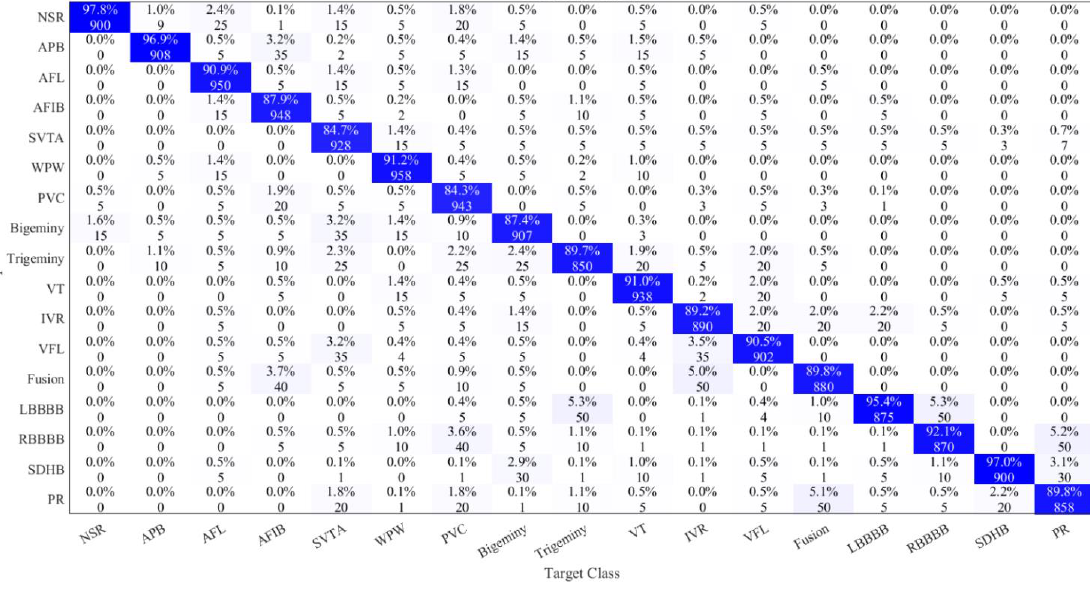
Figure 11. Confusion matrix of ArrhythmiaNet without the attention